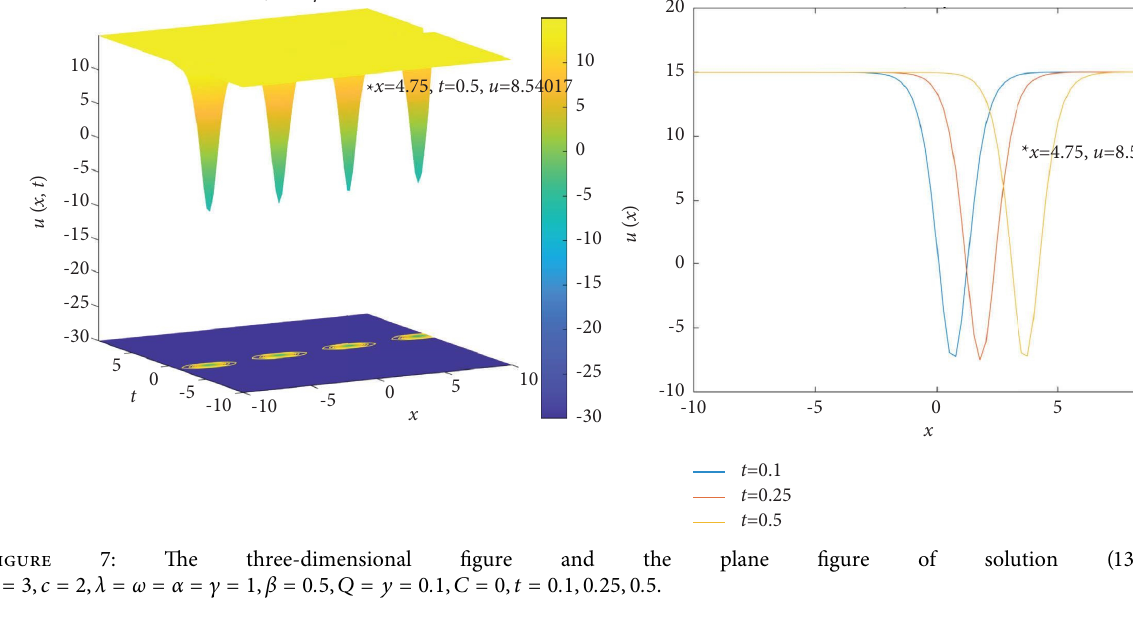
Te three-dimensional fgure and the plane fgure of solution